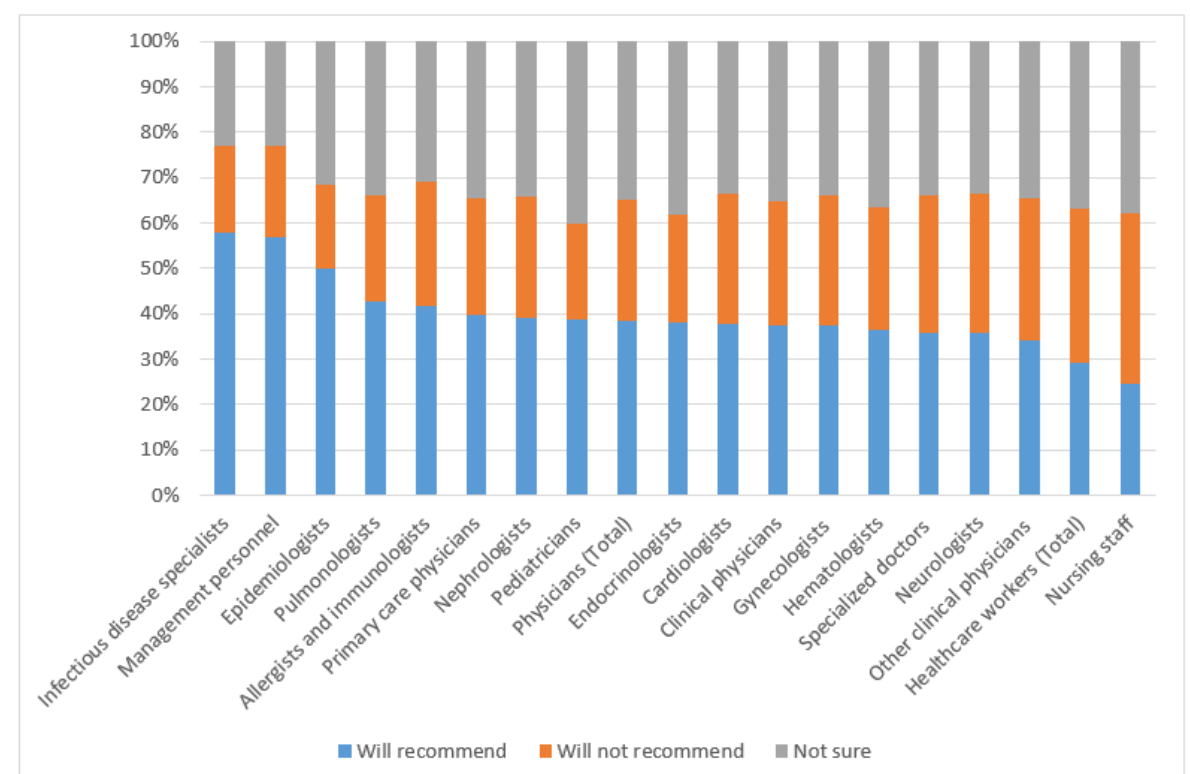
Figure 2. Willingness to promote vaccination against COVID-19 .